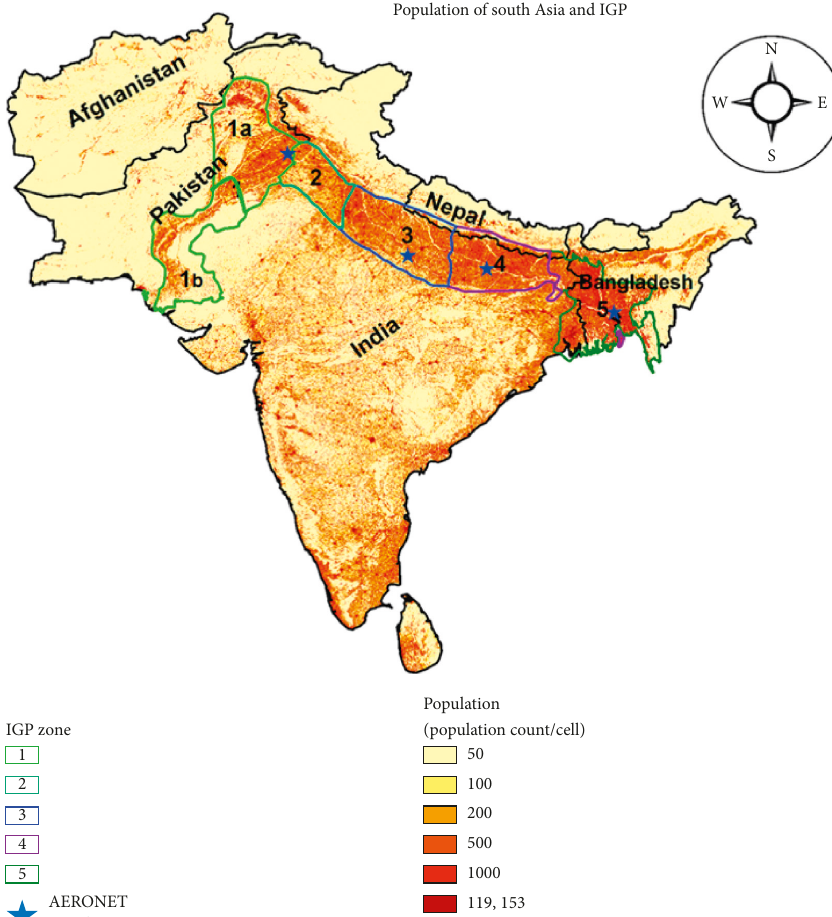
Figure 4: Six major subregions of the IGP based on population density, adopted from Khokhar and Yasmin, 2018.